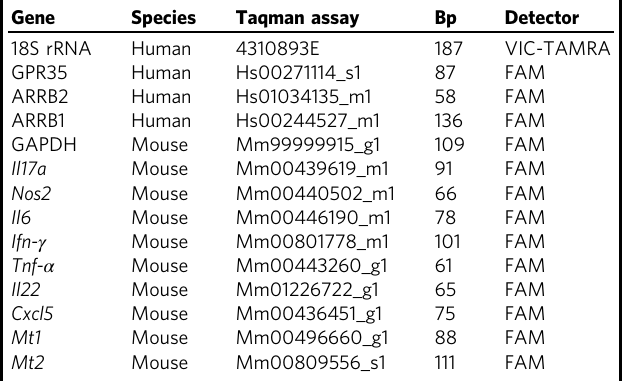
Table 3 Taqman assays for